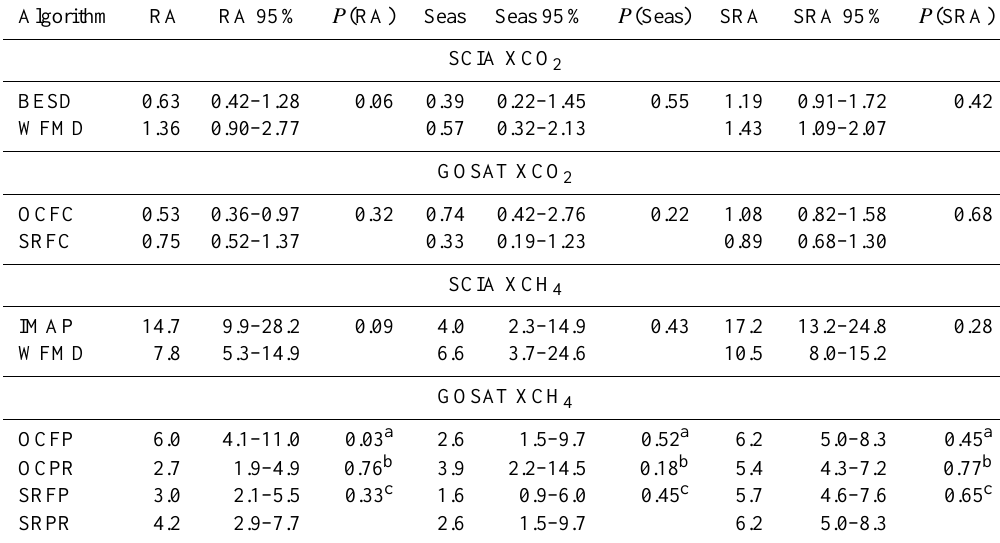
Table 14. Overview table, listing the “relative accuracy” (RA), overall “seasonality” (Seas) and “seasonal relative accuracy” (SRA), together with their 95% confidence interval (RA 95%, Seas 95% and SRA 95%) and the probability that the obtained sample variances stem from = σ 2 )) . The P values for the GOSAT XCH 4 results correspond to the following pairs: (a) OCFP vs. OCPR, the same population ( P(H 0 : σ 2 1 2 (b) OCPR vs. SRFP and (c) SRFP vs. SRPR.